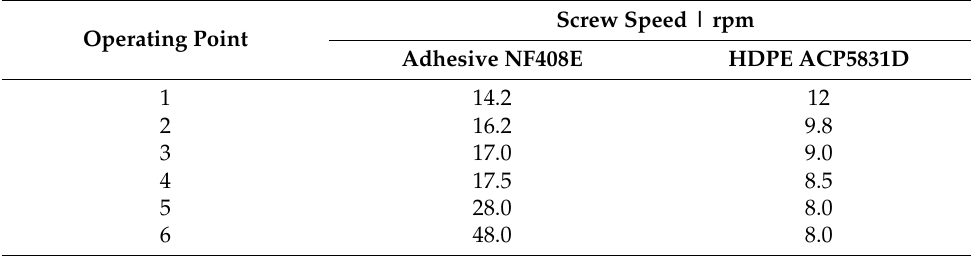
Table 5. Overview of the operating points under investigation (screw rotational